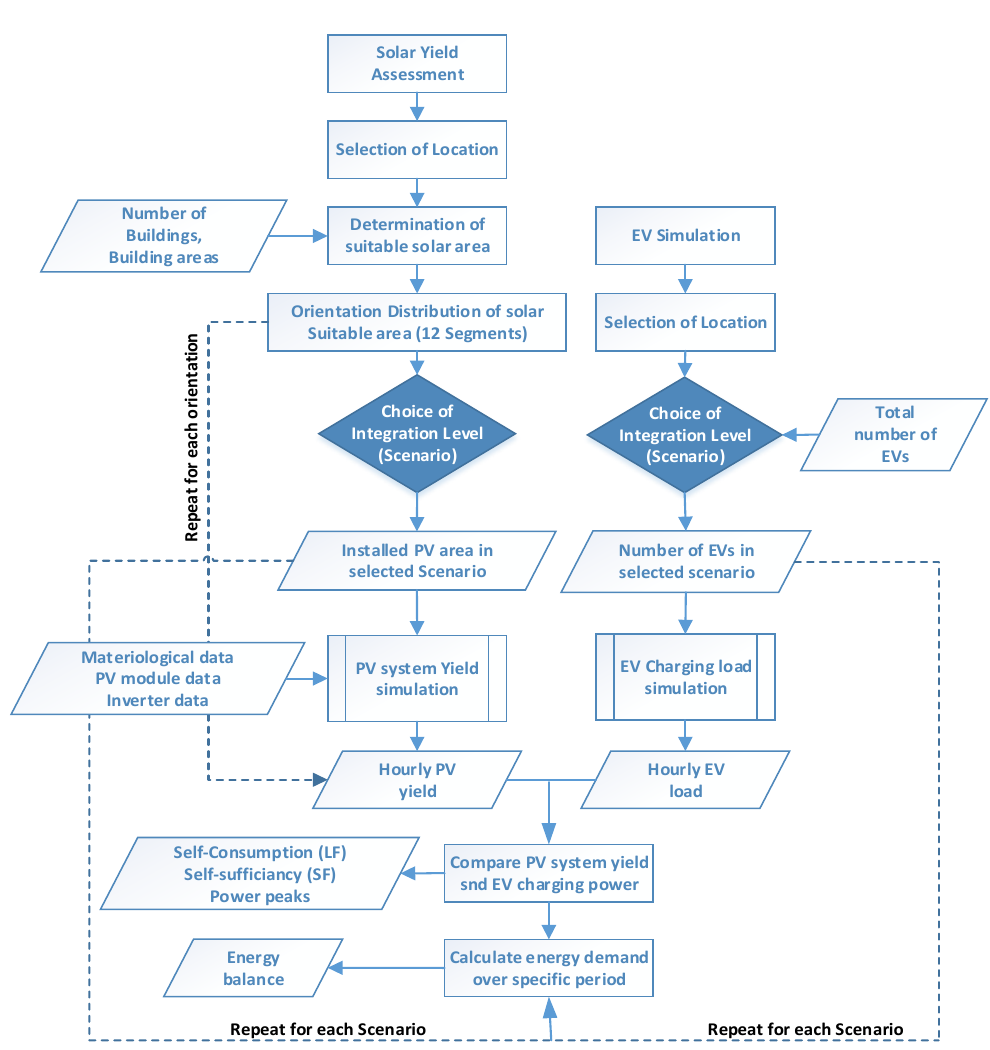
Figure 7. Flowchart for scenario based solar energy charging of EV.